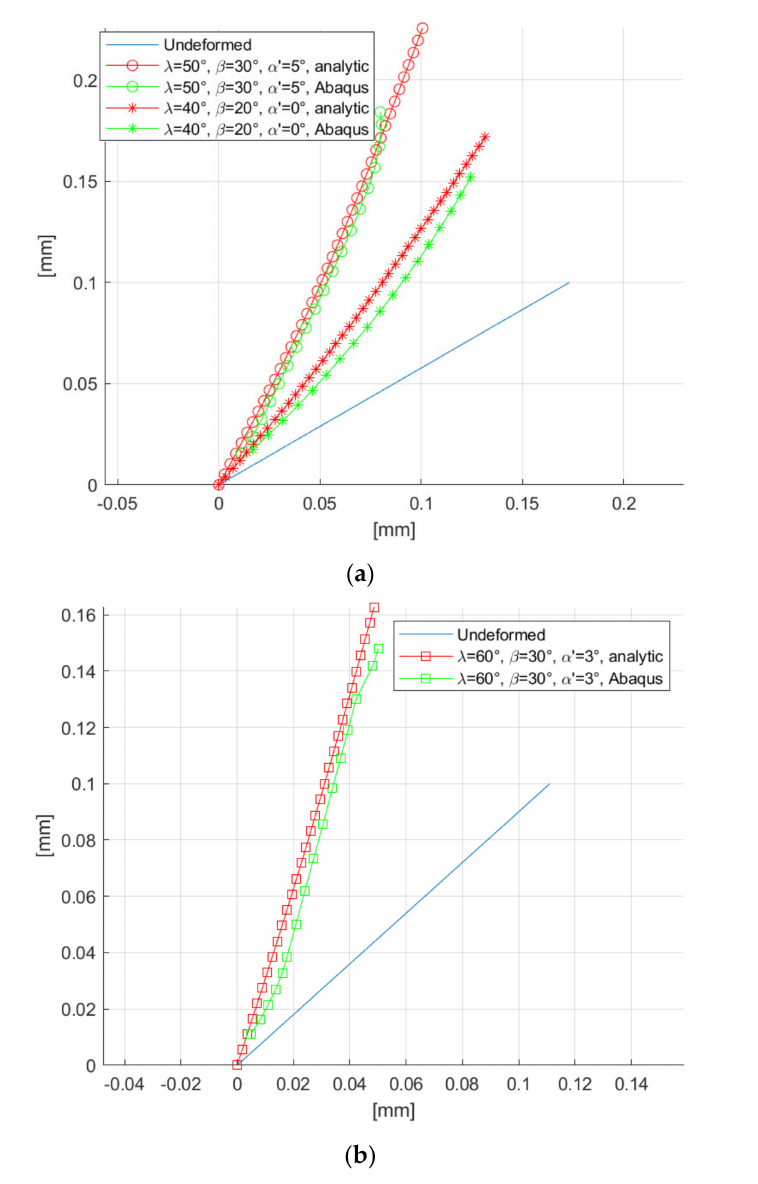
Figure 13. Validation of the proposed beam model for different cutting trajectories: λ (cid:48) = 30 ◦ ( a ) and λ (cid:48) = 42 ◦ ( b